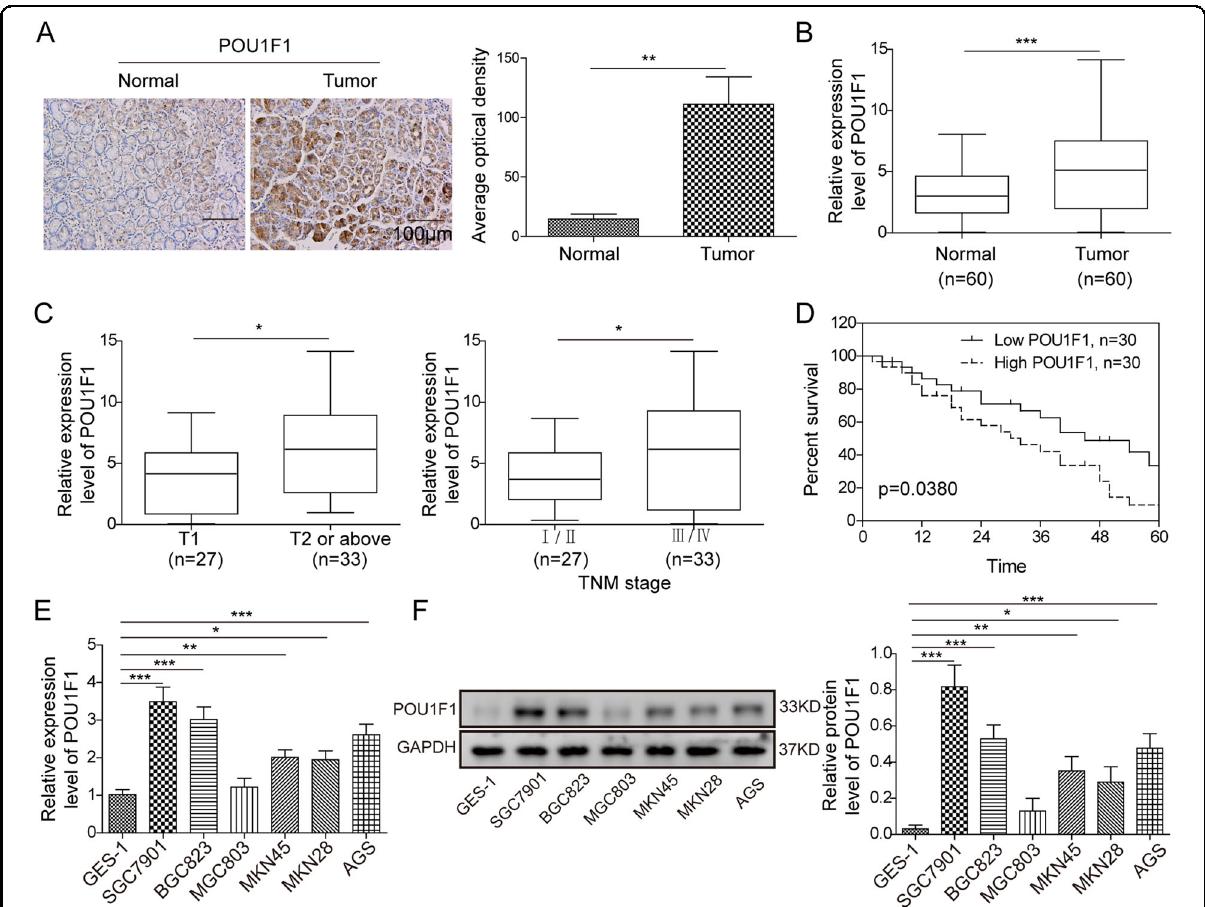
Fig. 1 Upregulated POU1F1 is associated with poor prognosis in GC. A Expression of POU1F1 in GC and paired adjacent normal tissues were determined by IHC. B The mRNA level of POU1F1 in GC and paired adjacent normal tissues were determined by qRT-PCR assay. C Expression patterns of POU1F1 in T1 or T2/above and different TNM stages were determined by qRT-PCR analysis. D Kaplan – Meier curves for overall survival of GC patients. E, F The mRNA and protein levels of POU1F1 in GC cell lines and GES-1 cells were examined using qRT-PCR and western blot analysis, respectively. GAPDH served as an internal control. Data were representative images or were expressed as the mean ± SD of n = 3 experiments. * P < 0.05, ** P < 0.01, *** P <